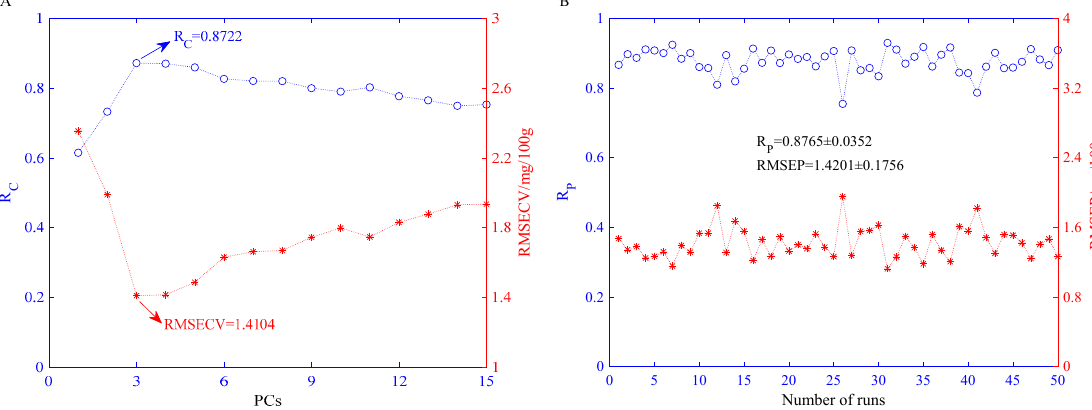
Figure 5. Statistical results of BPNN model based on olfactory visualization sensor data features after 50 independent runs. ( A ) Statistical results of BPNN models established under different PCs in the training set; ( B ) statistical results of the BPNN models established when PCs = 3 in the prediction set.